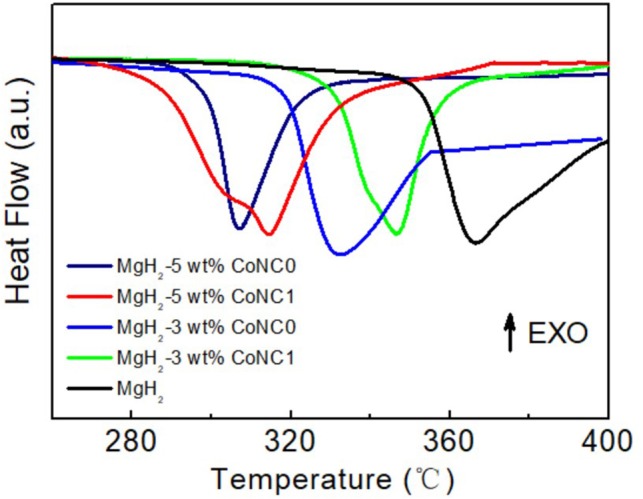
DSC curves of the pure MgH2, MgH2-3 wt% CoNC0, MgH2-5 wt% CoNC0, MgH2-3 wt% CoNC1, and MgH2-5 wt% CoNC1 composites at a heating rate of 5°C min−1.